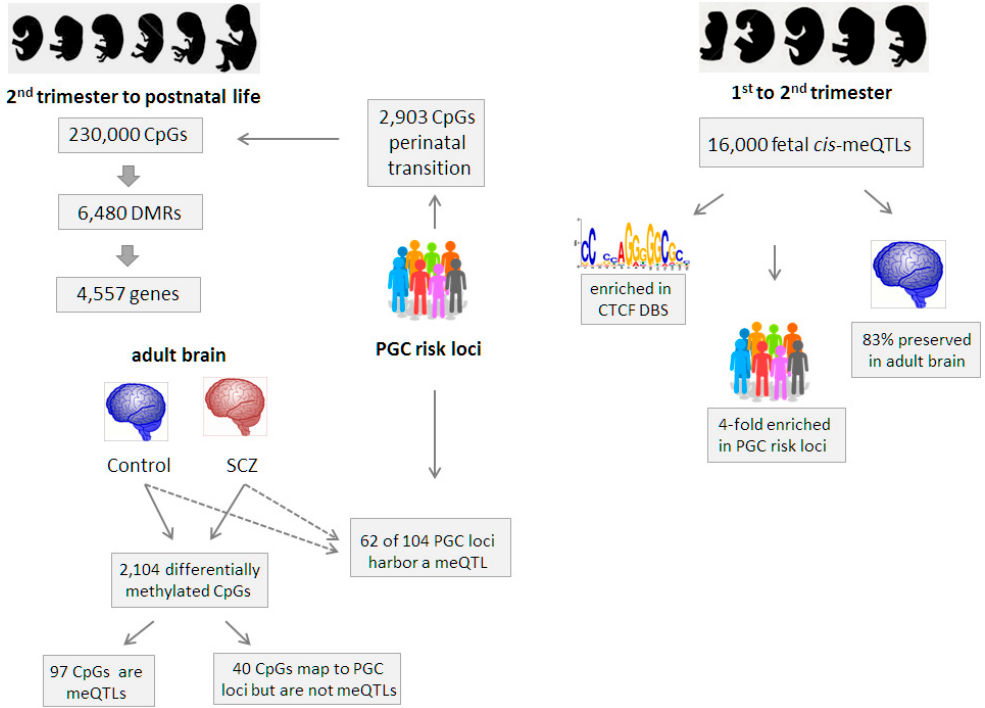
Figure 3. Findings on CpG methylation and on meQTLs in fetal and adult brains from control and SCZ individuals. Results from Jaffe el al. [52] ( left ) and from Hannon et al. [51] ( right ) are schematically summarized. In adult brain 62 of 104 Psychiatric Genomics Consortium (PGC) loci harbor a meQTL independent of case control status and fetal meQTLs are four-fold enriched in PGC risk loci. CTCF: CCCTC-binding factor; DBS: DNA binding site.